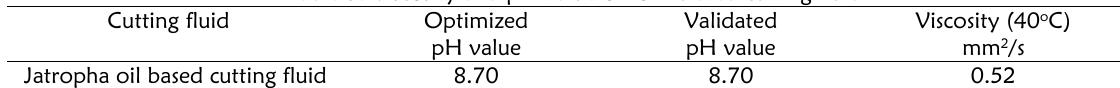
Table 7: Viscosity and pH value of formulated cutting fluid